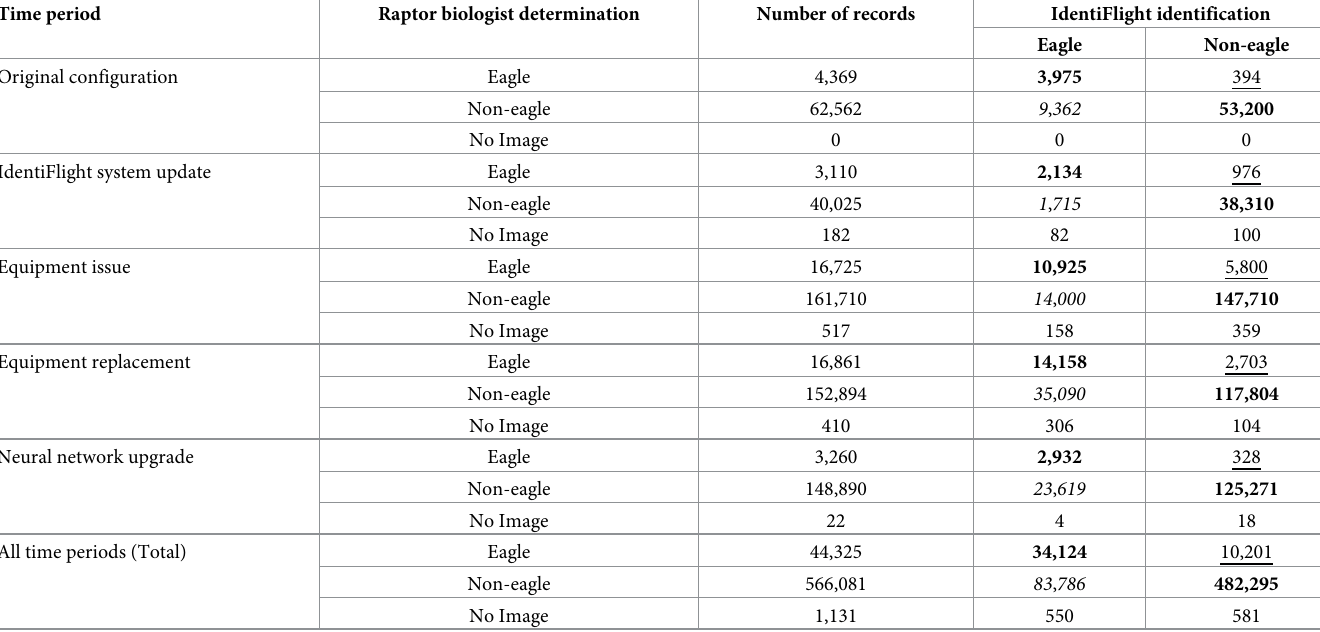
Table 2. Counts of correct (bold) and incorrect identifications of eagles and non-eagles by the IdentiFlight system for each of five time periods, at the Manzana Wind Power Project, California, USA. Incorrect identifications included targets in which eagles were misidentified as non-eagles (false-negative errors, underlined) and non-eagles misidentified as eagles (false-positive errors, italics). Instances in which raptor biologists had no image to review were omitted from the analysis.